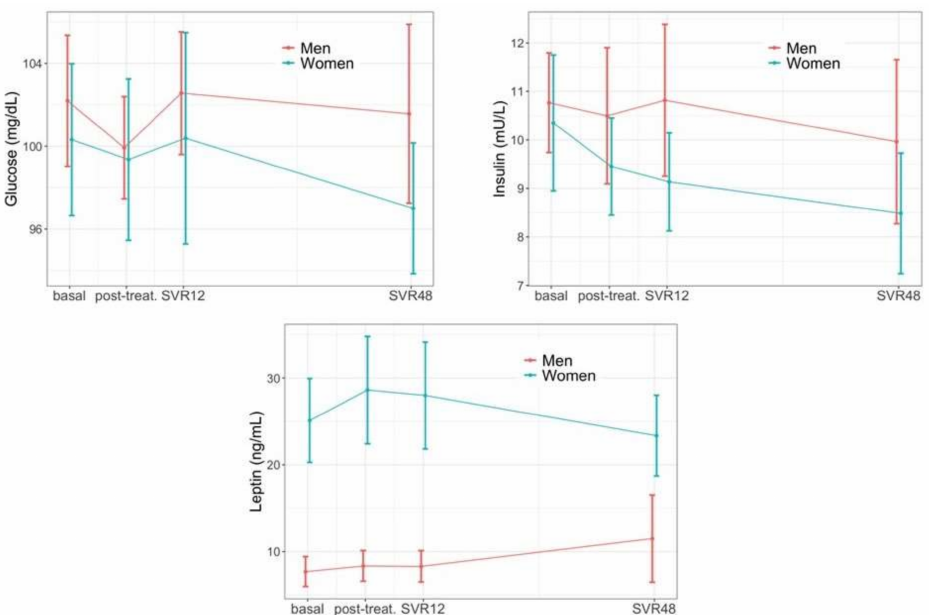
Figure 3. Glycemic profile changes during follow up. The levels of serum iron, ferritin and transferrin saturation decreased significantly during follow-up (all p long < 0.001), while transferrin was unaffected (Figure 4). It is worth noting that, compared to men, women had significant increased transferrin (p sex = 0.003) and reduced values of serum iron (p sex = 0.005), ferritin (p sex < 0.001), and transferrin saturation (p sex < 0.001) throughout the follow-up. We also observed a sex-specific effect in the magnitude of the reduction in the transferrin saturation (14% vs. 2.1% for men and women, respectively, p long*sex =